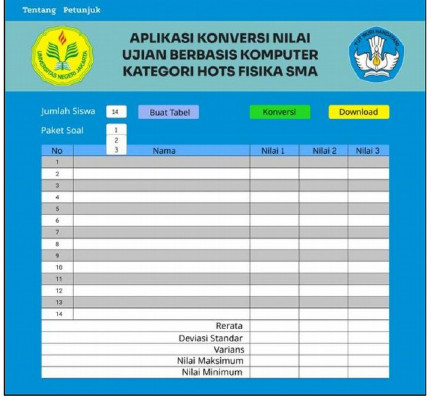
Figure 8. Display equating application